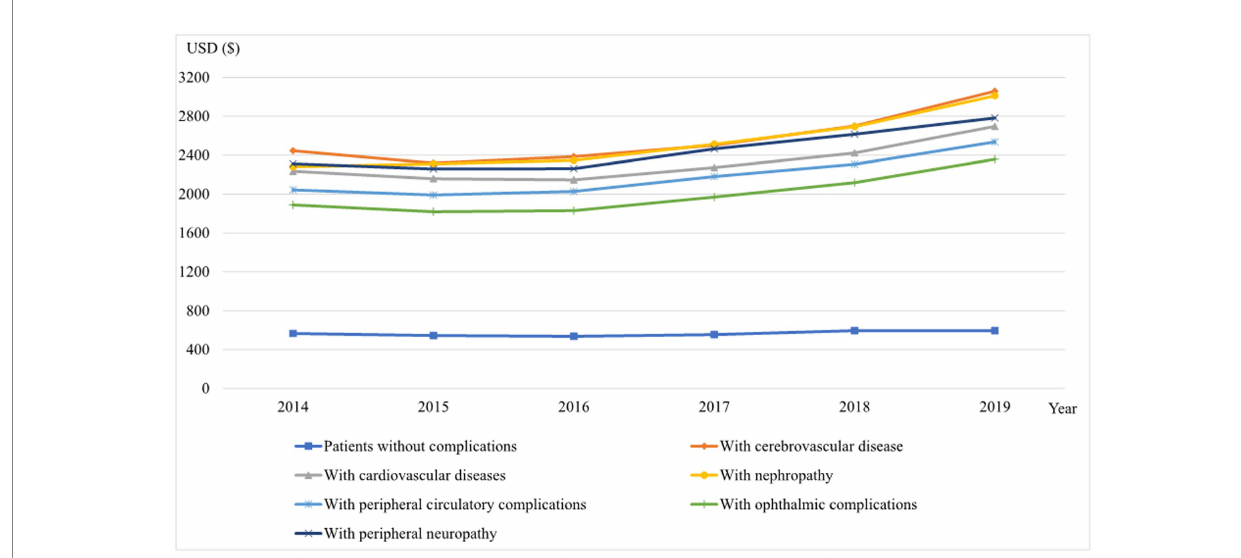
FIGURE 2 The average annual DM costs of diabetic patients with different types of diabetes-related complications, 2014–2019